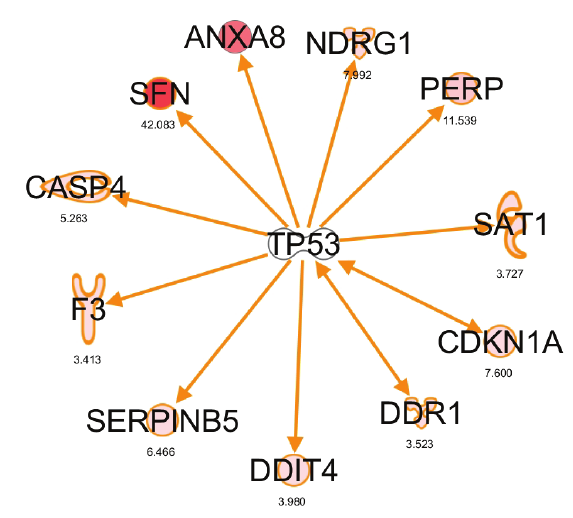
Figure S3. p53-linked expression changes. IPA-based rendering of mRNAs contained in the 5× datasets that were previously shown to be regulated by